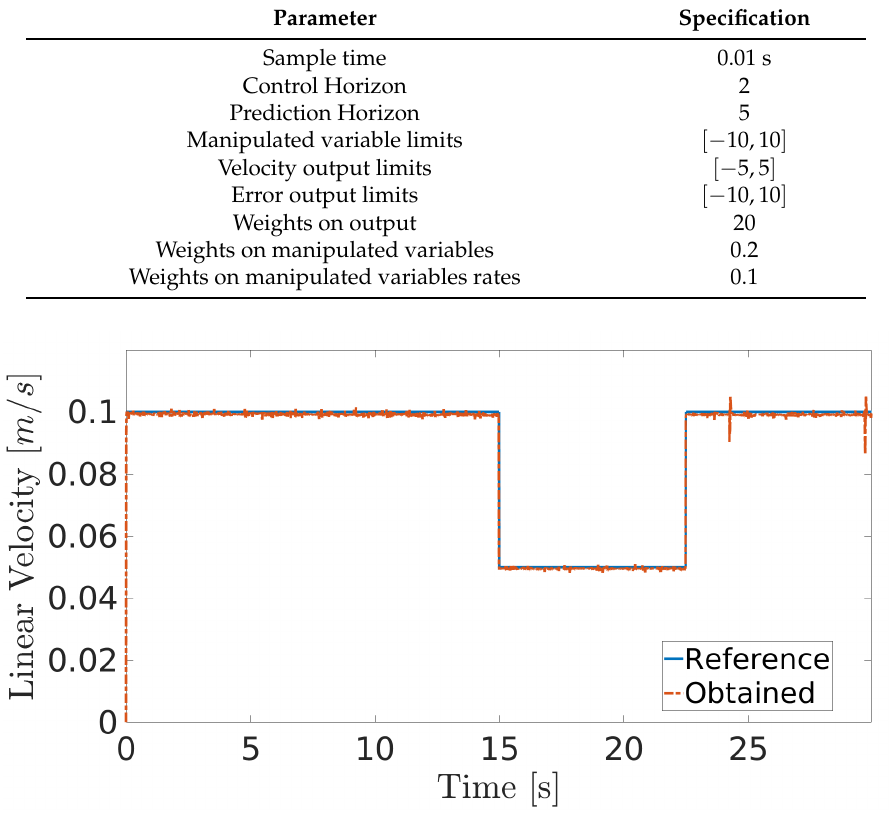
Figure 8. Linear velocity during navigation of the climbing robot in the storage tank.